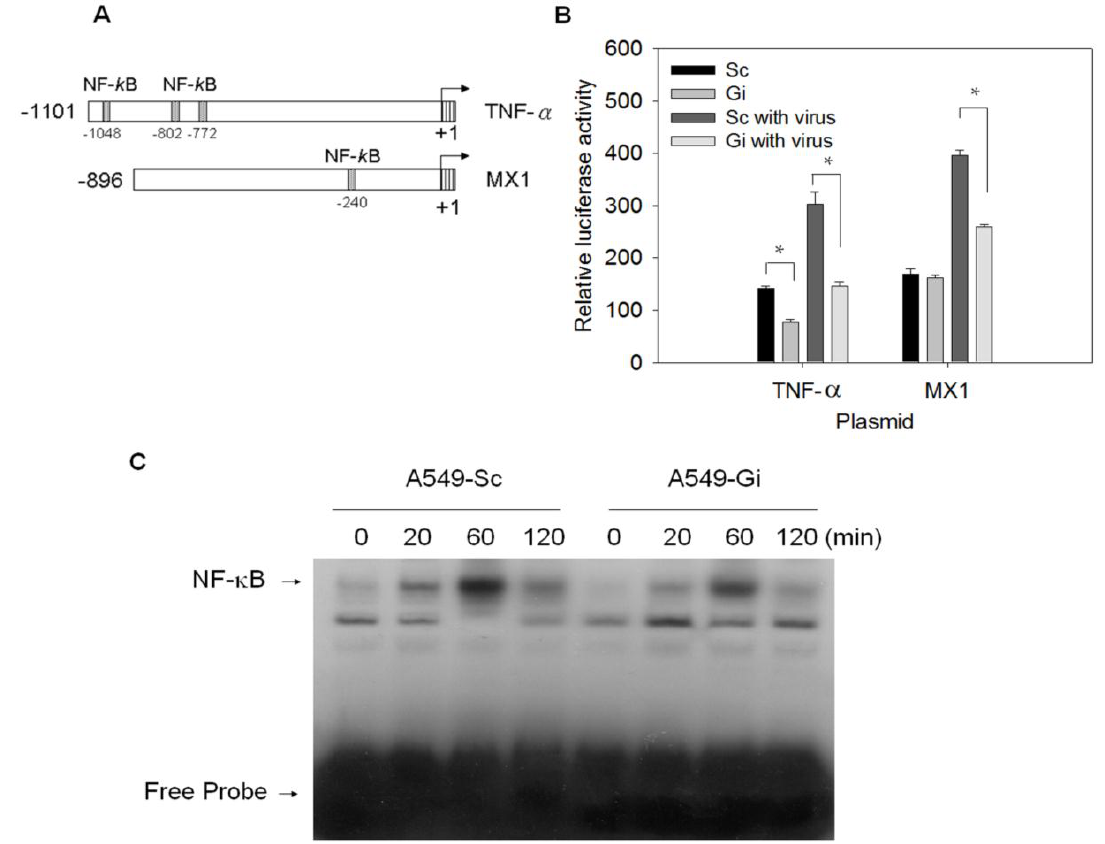
Figure 3. Promoter activities of antiviral genes, TNF- α and MX1 , and NF-κB binding activity is highly correlated with G6PD status upon HCoV 229E infection. ( A ) Schematic presentation of the TNF-α (−1 to −1101) and MX1 (−1 to −896) promoter region are shown. The transcriptional start site is marked with an arrow (+1). NF-κB binding sites are indicated with labeled boxes; ( B ) A549-Sc and -Gi cells were transfected with control, TNF-α and MX1 reporter plasmid for 24 h, and were untreated or infected with HCoV-229E at MOI of 0.1. Luciferase activity was analyzed at 24 h p. i., and expressed as mean ± SD ( n = 3) of fold change relative to vector control. * p < 0.05 as A549-Gi cells compared to A549-Sc cells alone or infected with virus, respectively; ( C ) A549-Sc and -Gi cells were infected with HCoV-229E at MOI of 0.1 for indicated periods. Nuclear extracts were prepared, and DNA binding activity was assayed by EMSA. DNA-protein complexes were resolved by eletrophoresis and detected by chemiluminescence.